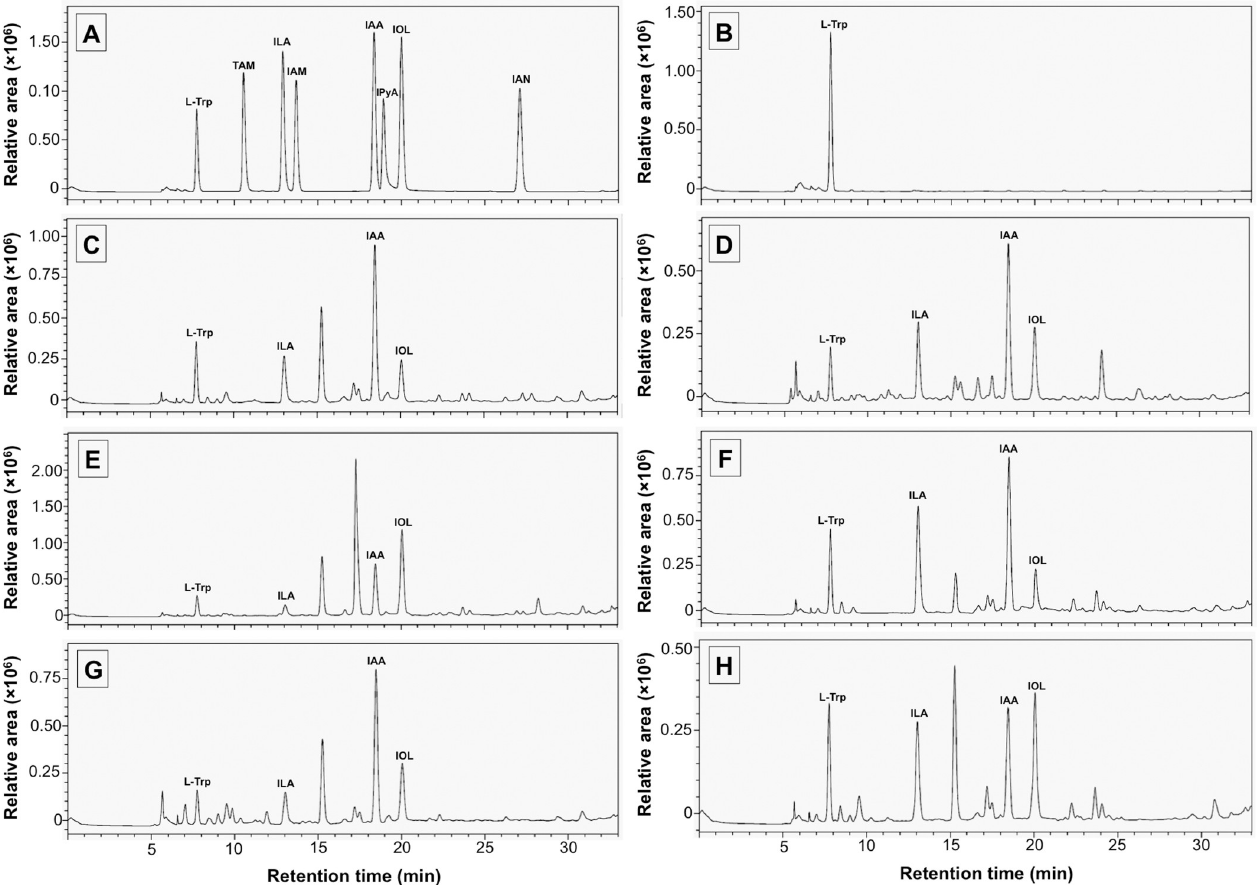
Fig 2. Identification of indole compounds produced by ectomycorrhizal fungi using high performance liquid chromatography technique. A. Indole compounds standard, B. Uncultivated liquid medium. C. Crude culture extract of Astraeus odoratus . D. Crude culture extract of Gyrodon suthepensis . E. crude culture extract of Phlebopus portentosus . F. Crude culture extract of Pisolithus albus . G. Crude culture extract of Pisolithus orientalis . H. crude culture extract of Scleroderma suthepense . L-Trp = L-tryptophan, TAM = tryptamine, IAM = indole-3-acetamide, ILA = indole-3-lactic acid, IPyA = indole-3-pyruvic acid, IAA = indole-3-acetic acid, IOL = indole-3-ethanol and IAN = indole-3-acetonitrile. The analyses were performed in triplicate.